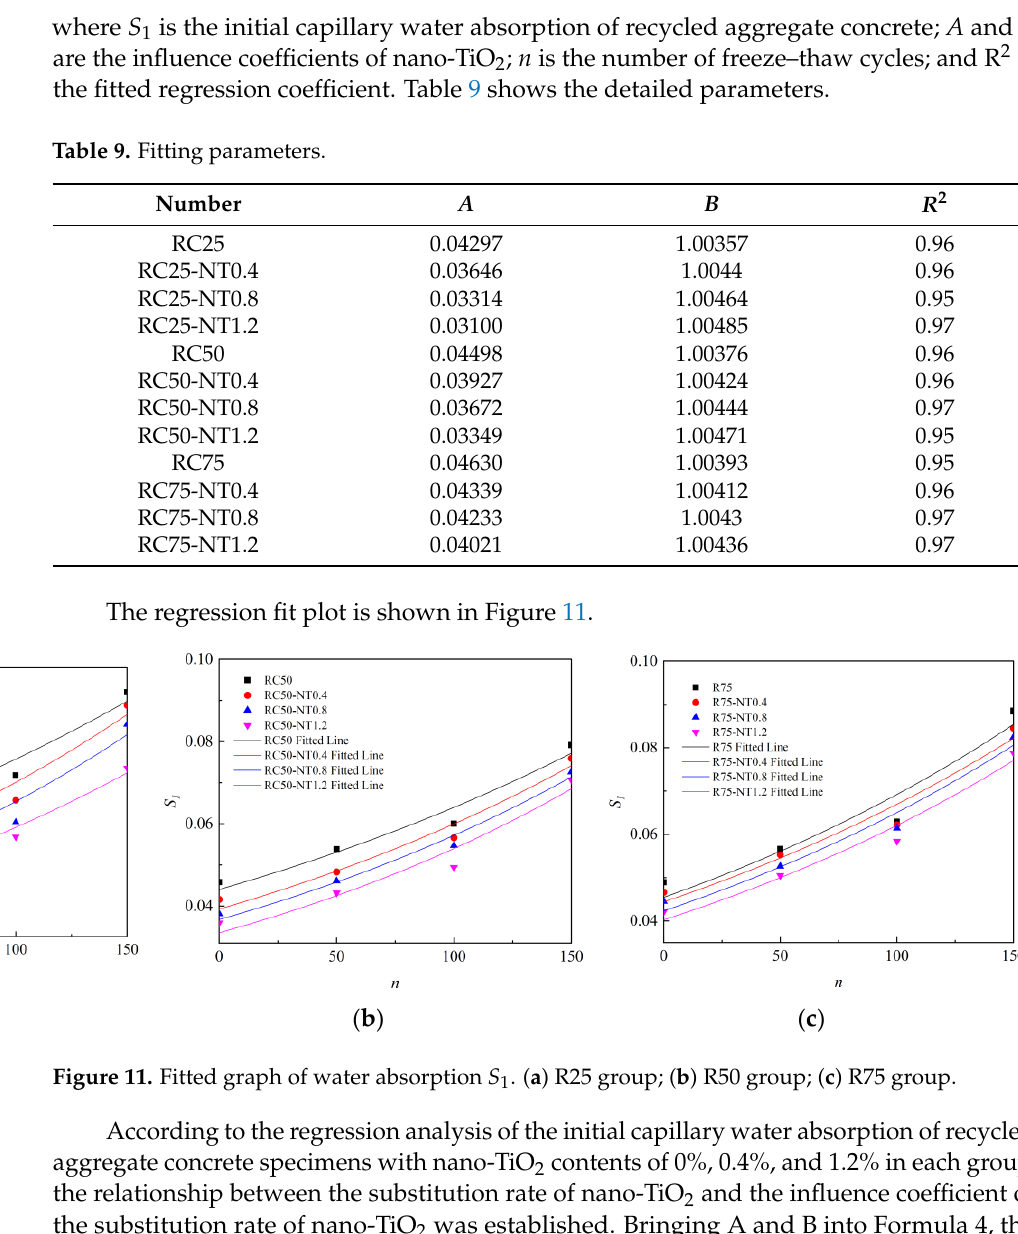
Table 10. Prediction model of initial capillary water absorption of Nano-TiO 2 recycled aggregate concrete.